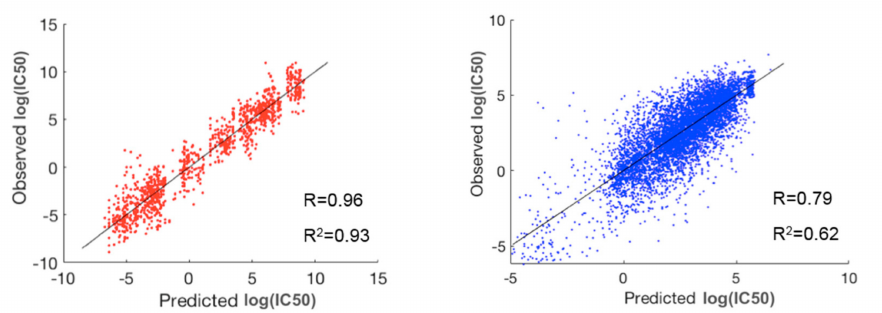
Figure 3. The best (red) and worst (blue) clusters among the 30 paired clusters with respect to prediction accuracy. The best prediction lies in the pair of cell-line cluster 3 (mainly glioma and melanoma) and drug cluster 1. The worst prediction lies in the pair of cell-line cluster 6 (mainly consisting of breast, head and neck, large intestine, and stomach cancers) and drug cluster 5.